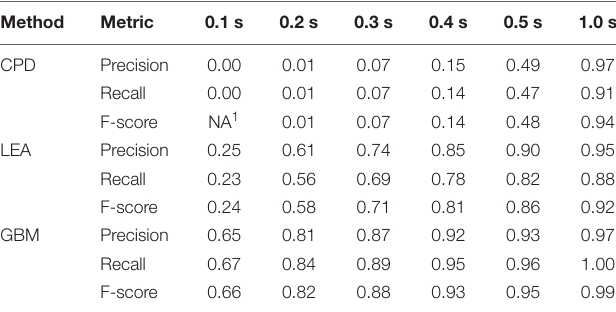
TABLE 1 | Performance results of the step detection methods for different allowed distances (in seconds) from the annotated